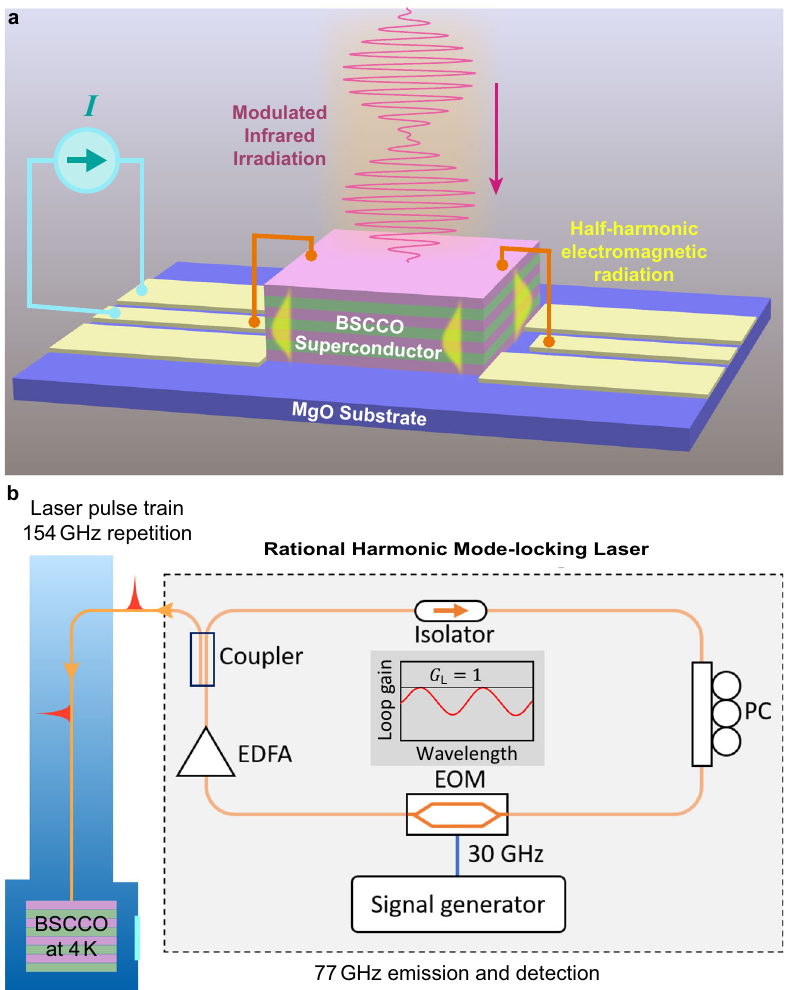
Fig. 7 Experimental scheme of a parametrically modulated stack of multi-layer long and wide Josephson junctions in BSCCO. a Schematics of a laser- pumping induced space − time crystal in BSCCO. b Proposed setup to achieve 154 GHz laser modulation from 30.8 GHz using the rational harmonic generation technique and to detect the half-harmonic generation either with a Fourier-transform infrared spectroscopy or autocorrelation setup. Inset shows the loop gain pro fi le with a sinusoidal line shape originating from the EOM modulation. The amplitude condition for lasing is satis fi ed when the gain pro fi le equals unity ( G L =